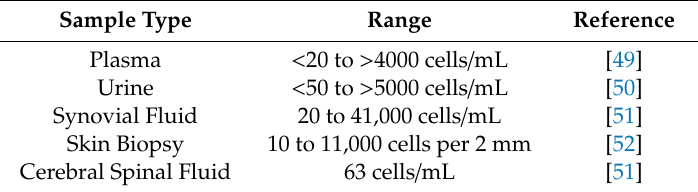
Table 2. Estimates of B. burgdorferi cell count in various clinical sample